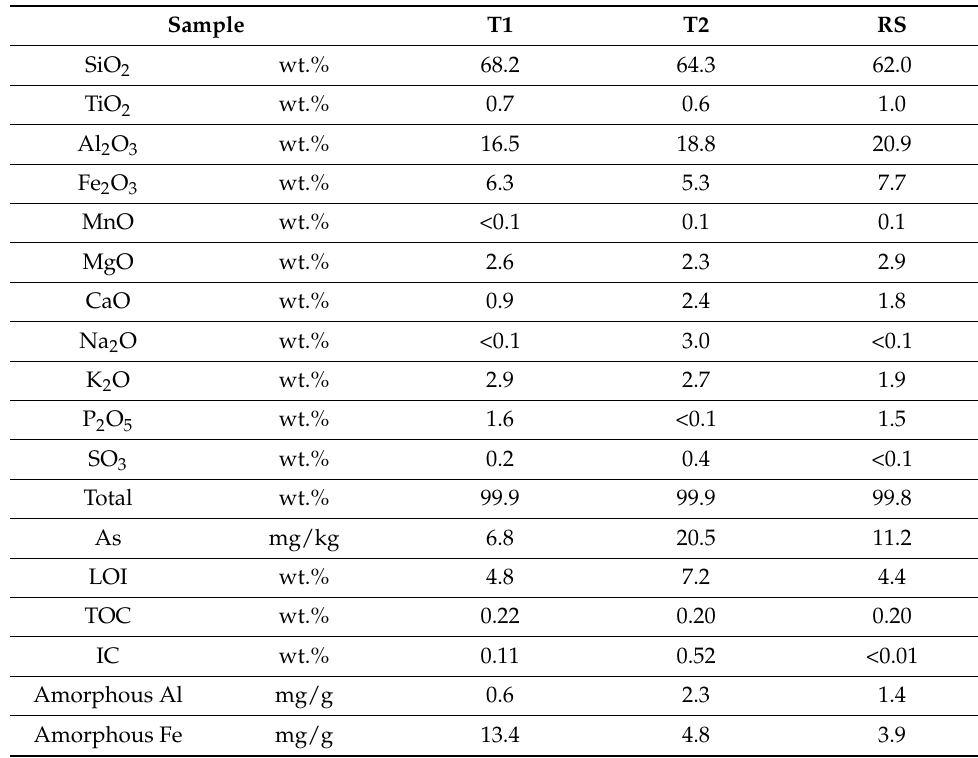
Table 2. Chemical composition of excavated rock and RS (river sediment) samples.